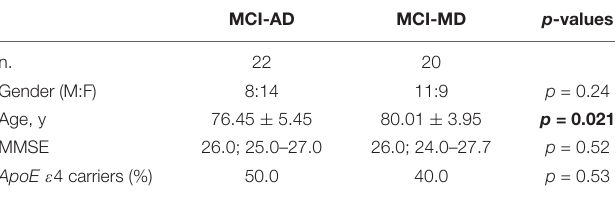
TABLE 2 | Demographic and clinical characteristics of the MCI evolved in dementia. MCI-AD MCI-MD p